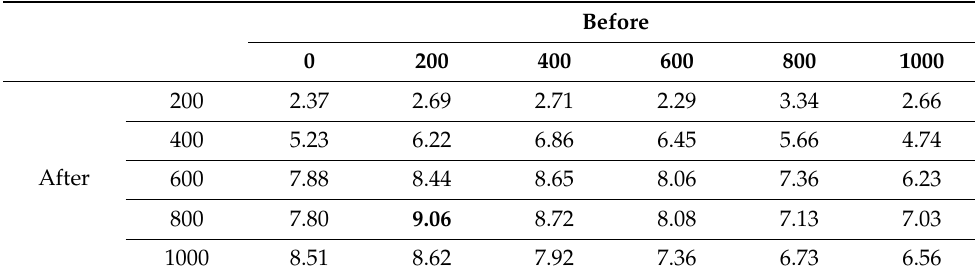
Table 4. The perceived naturalness of the male model. The bold text with a large font means the highest value.